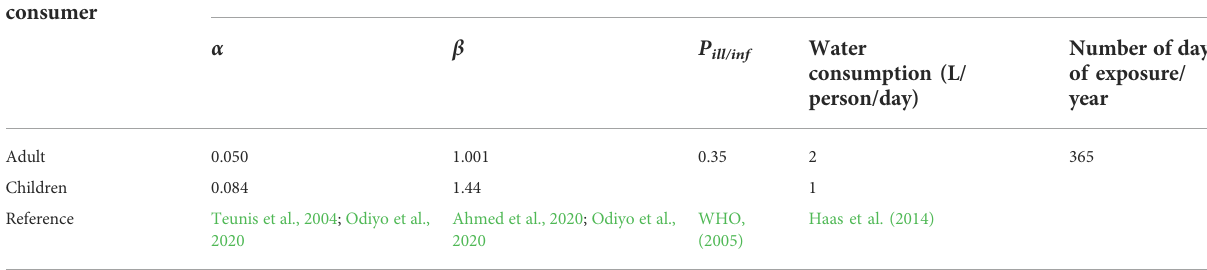
TABLE 2 Parameters used in the quantitative microbial risk assessment for pathogenic E.